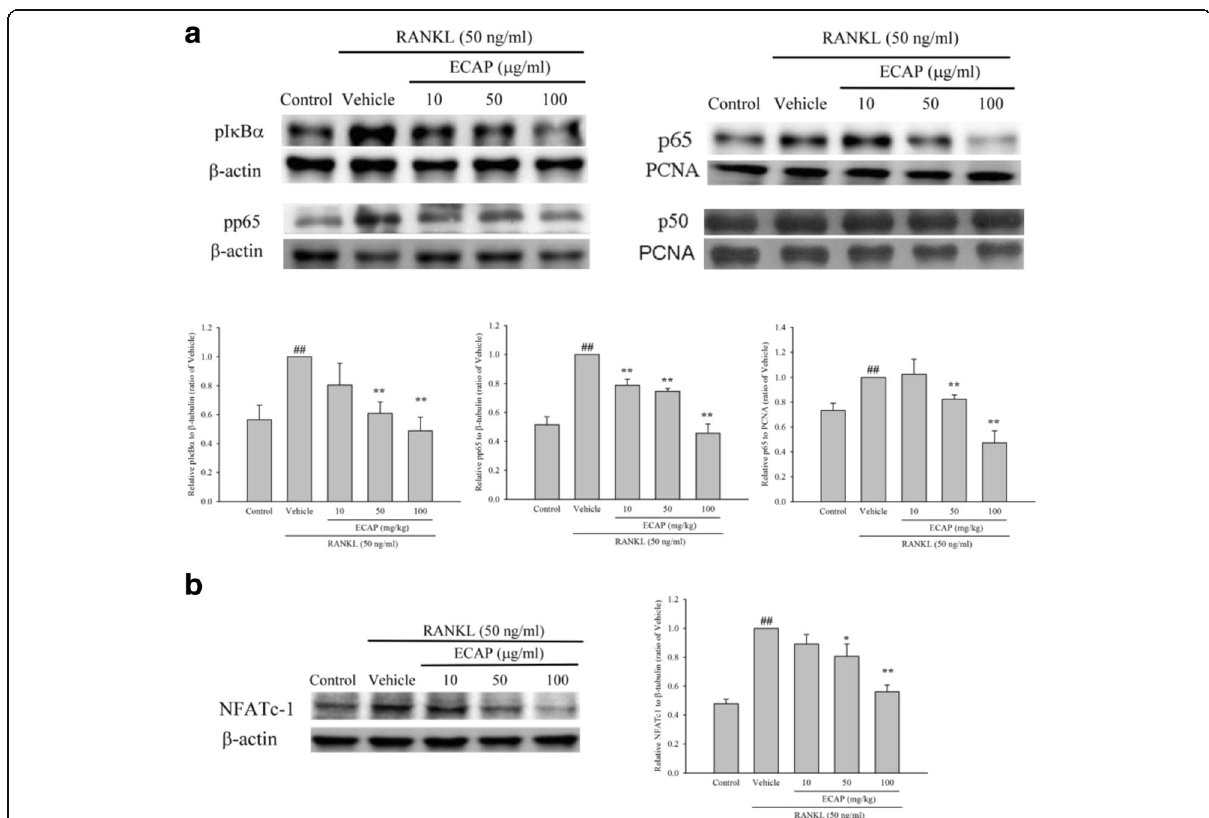
Fig. 4 Effects of ECAP on RANKL-induced NF- κ B and NFATc1 activation. a RAW 264.7 cells were pre-incubated for 1 h with indicated concentrations of ECAP and then activated for 1 h with RANKL (50 ng/ml). Cytoplasm fractions were obtained for the detection of phospho-I κ B α , phospho-p65 and β -actin levels. Nuclear fractions were obtained for the detection of p65, p50 and PCNA levels. b RAW 264.7 cells were pre-incubated for 1 h with indicated concentrations of ECAP and then activated for 24 h with RANKL (50 ng/ml). The cell lysates were obtained for the detection of NFATc1 levels. Each value represents the mean ± SD. ( n = 3). ## P < 0.01 compared with control; * P < 0.05, ** P < 0.01 compared with RANKL alone